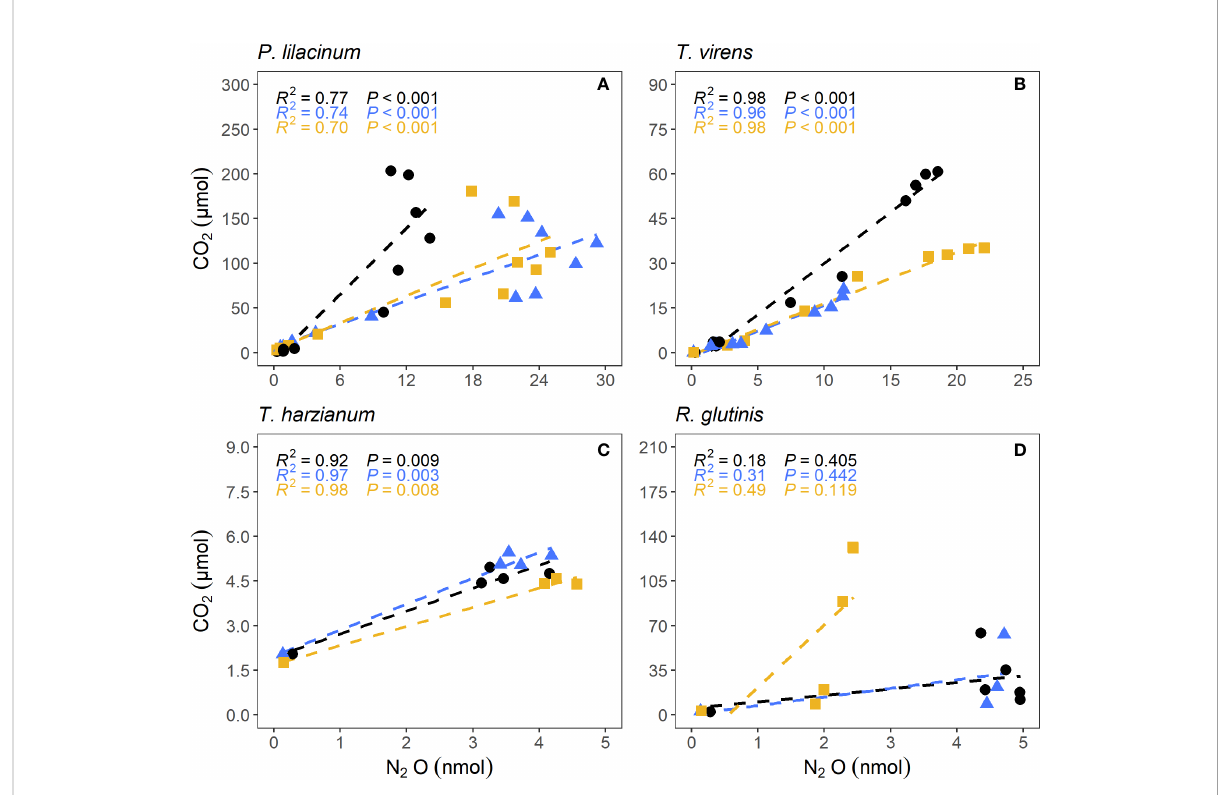
FIGURE 3 Correlation between N 2 O and CO 2 production by salt marsh sediment fungi P. lilacinum (A) , T. virens (B) , T. harzianum (C) , and R. glutinis (D) . Each color represents one of the three